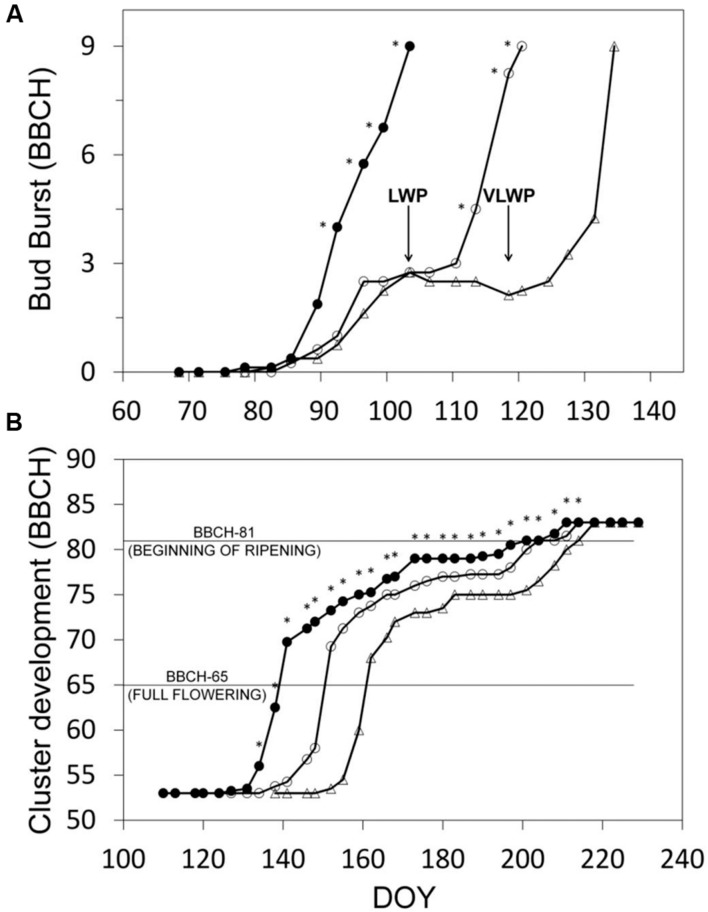
Progression to bud-burst (BBCH-09) (A) and through the reproductive stages (B) for the three pruning treatments. Estimates in (B) fall within the interval between BBCH-53 (inflorescences clearly visible) and BBCH-83 (berries developing color). In (A), arrows indicate DOY of winter pruning for LWP and VLWP treatments. In (B), within date, asterisk indicates mean separation at p ≤ 0.05 by SNK or t-test according to the number of treatments (3 or 2, respectively). No asterisk means ns.